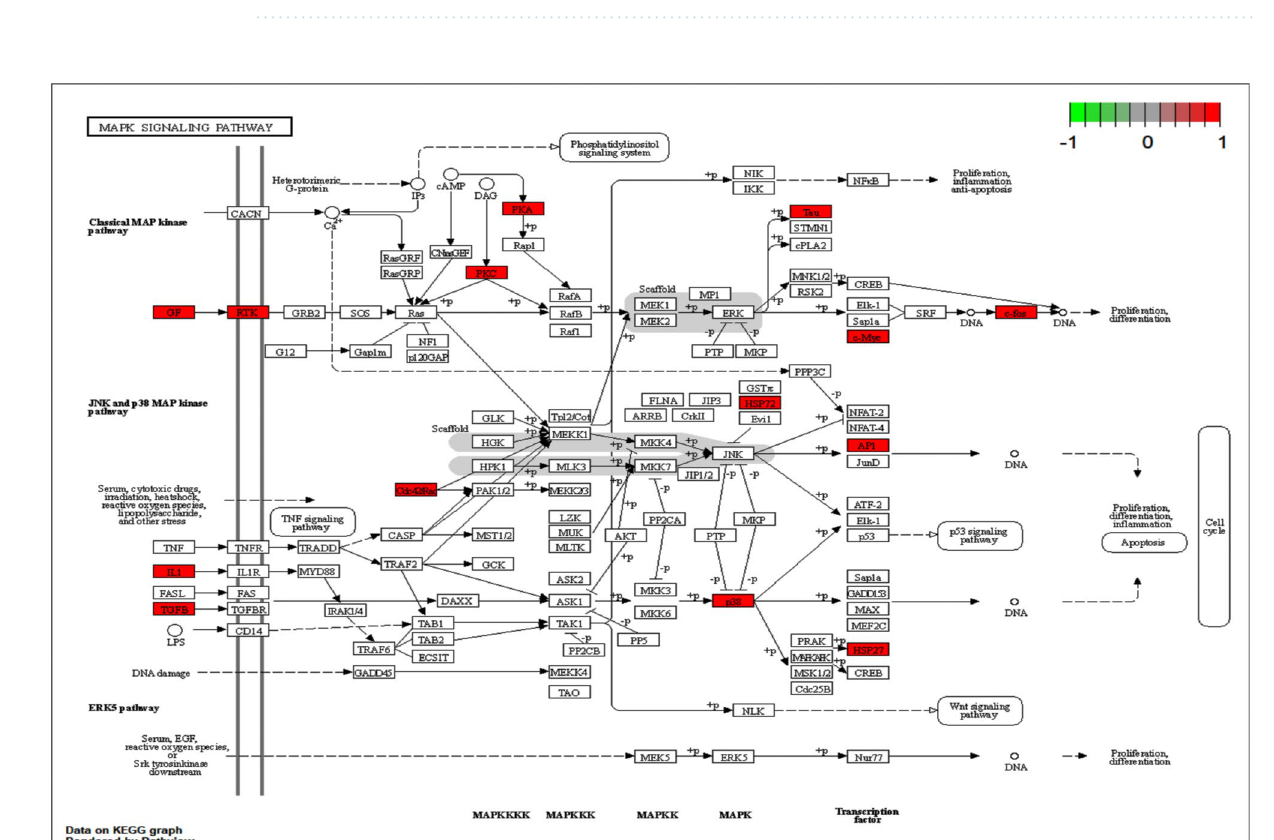
Table 2. KEGG pathway enrichment analysis of Que against AF.